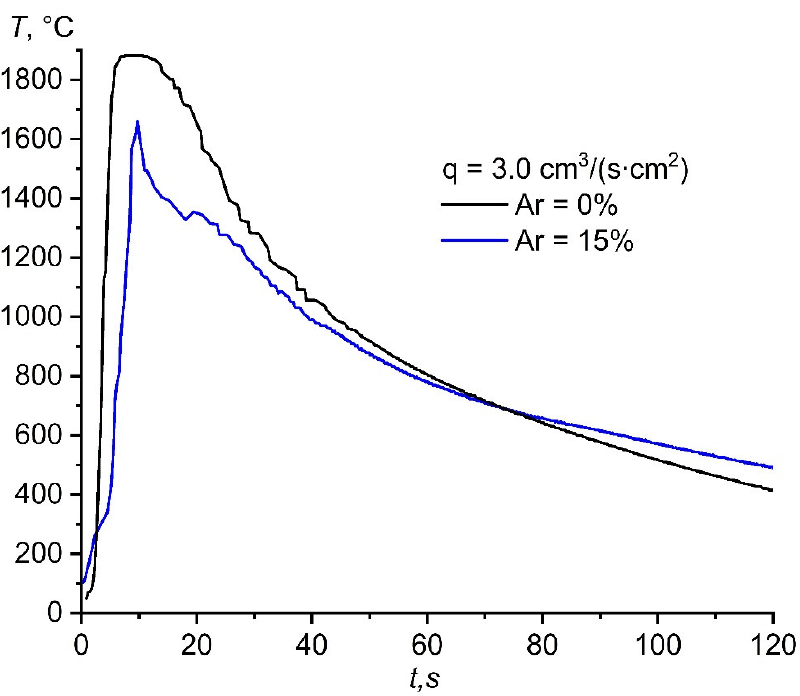
Figure 8. Heat patterns obtained during combustion of the (70% AlN + 30% Al) sample in the flow of nitrogen and nitrogen–argon mixture.